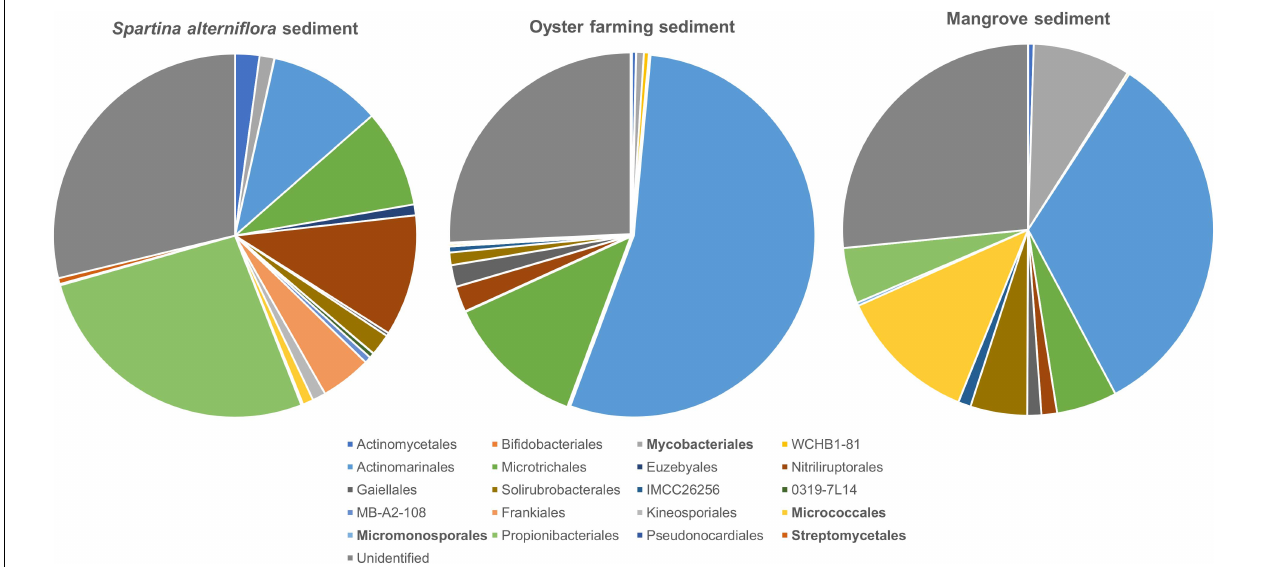
FIGURE 5 | Taxonomic classification and relative abundance of Actinobacteria at the order level identified from the three habitats. The numbers of ASVs belonging to Actinobacteria found in S. alterniflora sediment, oyster farming sediment, and mangrove sediment are 511, 329, and 195, respectively. The taxonomy was assigned based on the SILVA database. The four orders detected by cultivations are marked